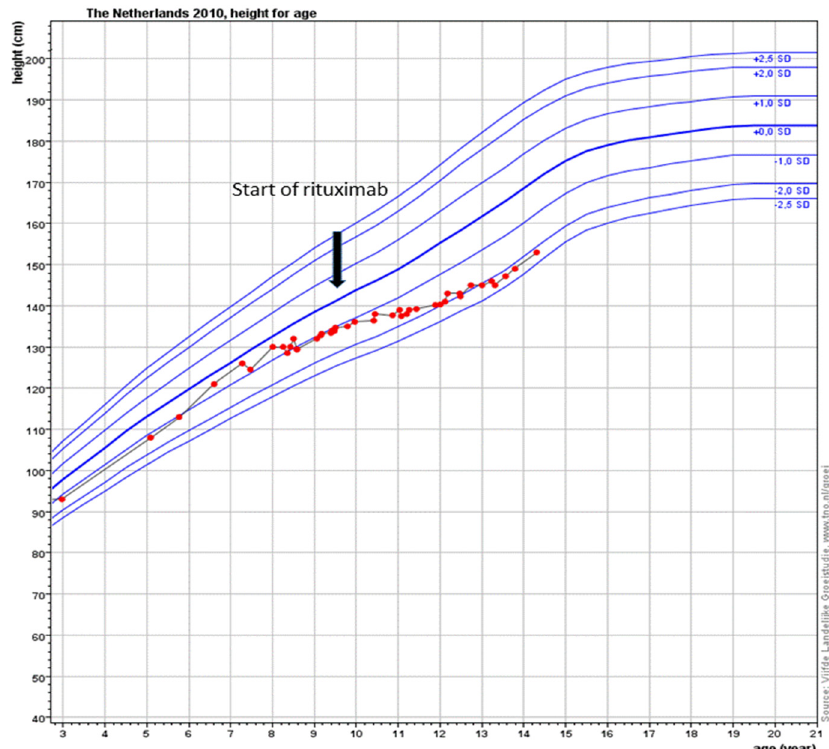
Figure 2. Lung function over time (forced expiratory volume in 1 s (FEV1) in blue and forced vital capacity (FVC) in red expressed as percent predicted of normal. FVC shows a gradual increase while FEV1 remains stable.